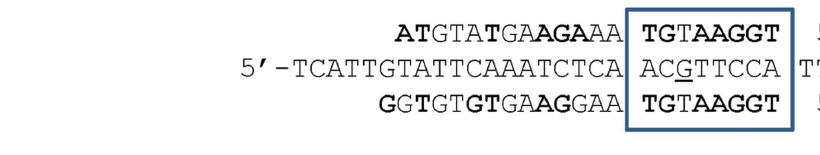
sequence).The eight nucleotide seed regions in the 5 (cid:48) end of the miRNA are boxed.The G to A mutation produces an illegitimate recognition site for these miRNA and miRNA mediated translational repression of MSTN